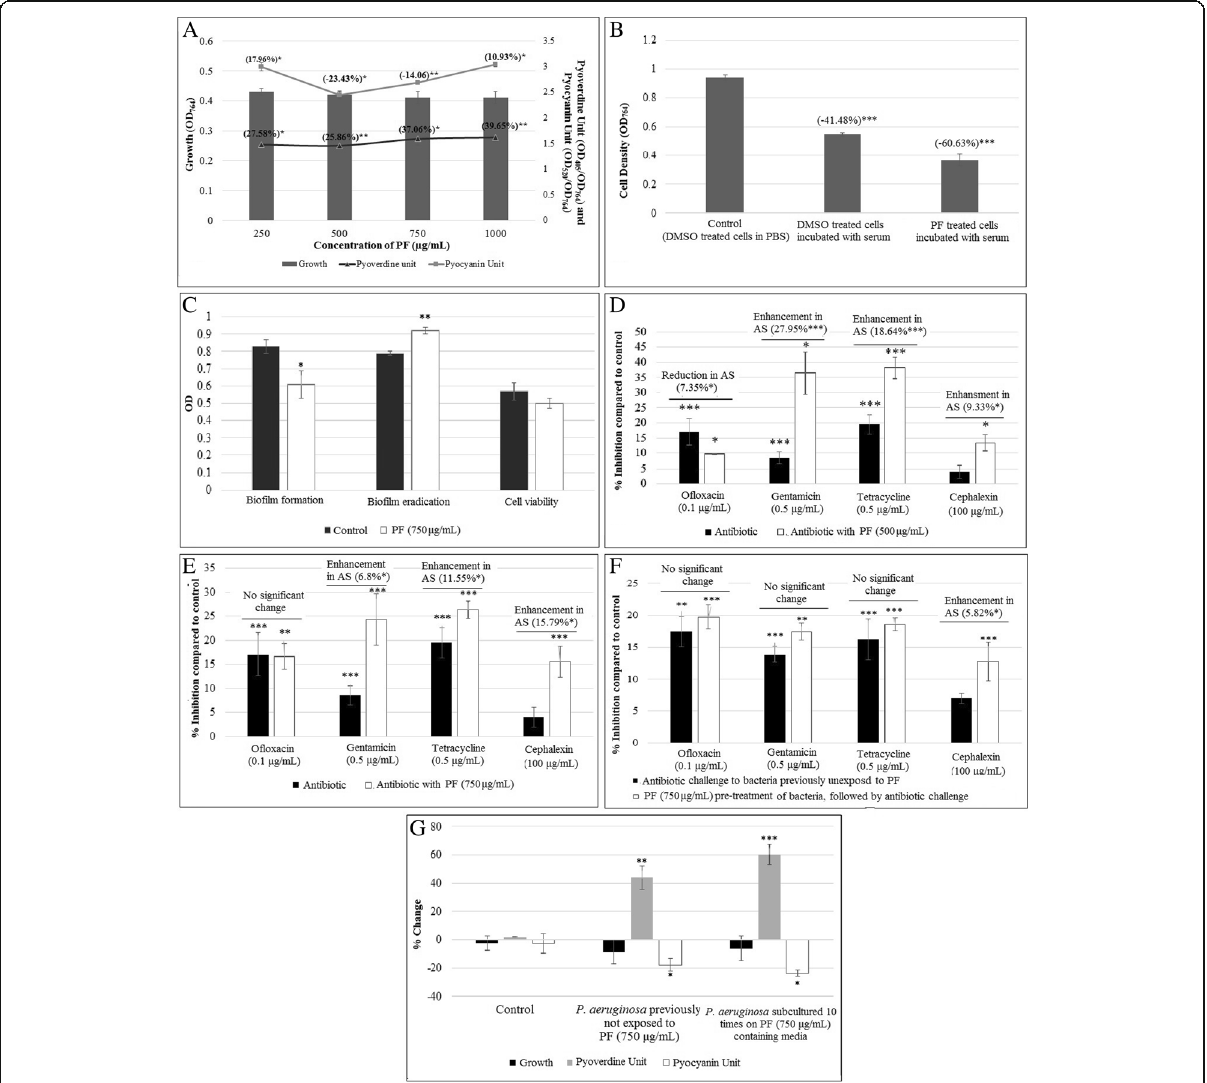
Fig. 1 Effect of Panchvalkal formulation (PF) on various traits of P. aeruginosa , in vitro . a . Effect of PF on growth and QS-regulated pigment production in P. aeruginosa. b . PF enhances susceptibility of P. aeruginosa to lysis in presence of human serum. c . Effect of PF (750 μ g/mL) on P. aeruginosa biofilm formation, eradication, and viability. d . P. aeruginosa challenged with PF (500 μ g/mL) and antibiotic together. e . P. aeruginosa challenged with PF (750 μ g/mL) and antibiotic together. f . P. aeruginosa challenged with antibiotic following pre-treatment with PF. g . Effect of PF on P. aeruginosa growth, pyoverdine unit, and pyocyanin unit remained unaltered after repeated exposure to PF. Bacterial growth was measured as OD 764 ; OD of pyoverdine was measured at 405nm, and Pyoverdine Unit was calculated as the ratio OD 405 /OD 764 (an indication of pyoverdine production per unit of growth), Pyocyanin Unit was calculated as the ratio OD 520 /OD 764 (an indication of pyocyanin production per unit of growth); ‘ Control ’ in this figure is the ‘ vehicle control ’ representing the % change values in comparison to the ‘ growth control ’ i.e. tube containing only growth medium plus organism, but no DMSO; 0.5% v /v DMSO used as ‘ vehicle control ’ did not affect biofilm of the bacterium; Crystal violet assay was performed to measure biofilm formation, and biofilm eradication, followed by the measurement of OD at 580nm; Cell viability in biofilm was estimated through MTT assay, wherein OD was measured at 540nm; * p <0.05, ** p <0.01, *** p